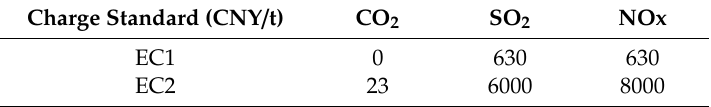
Table 6. Di ff erent standards of environmental pollution costs.